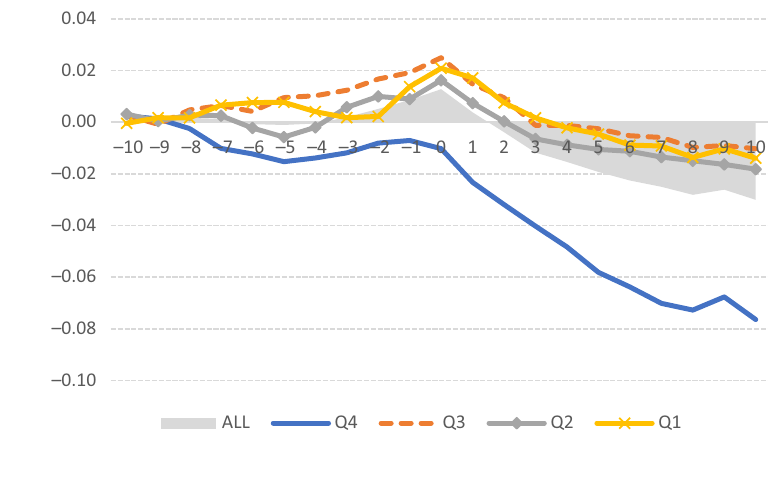
Figure 10. Post-split performance of issue size groups